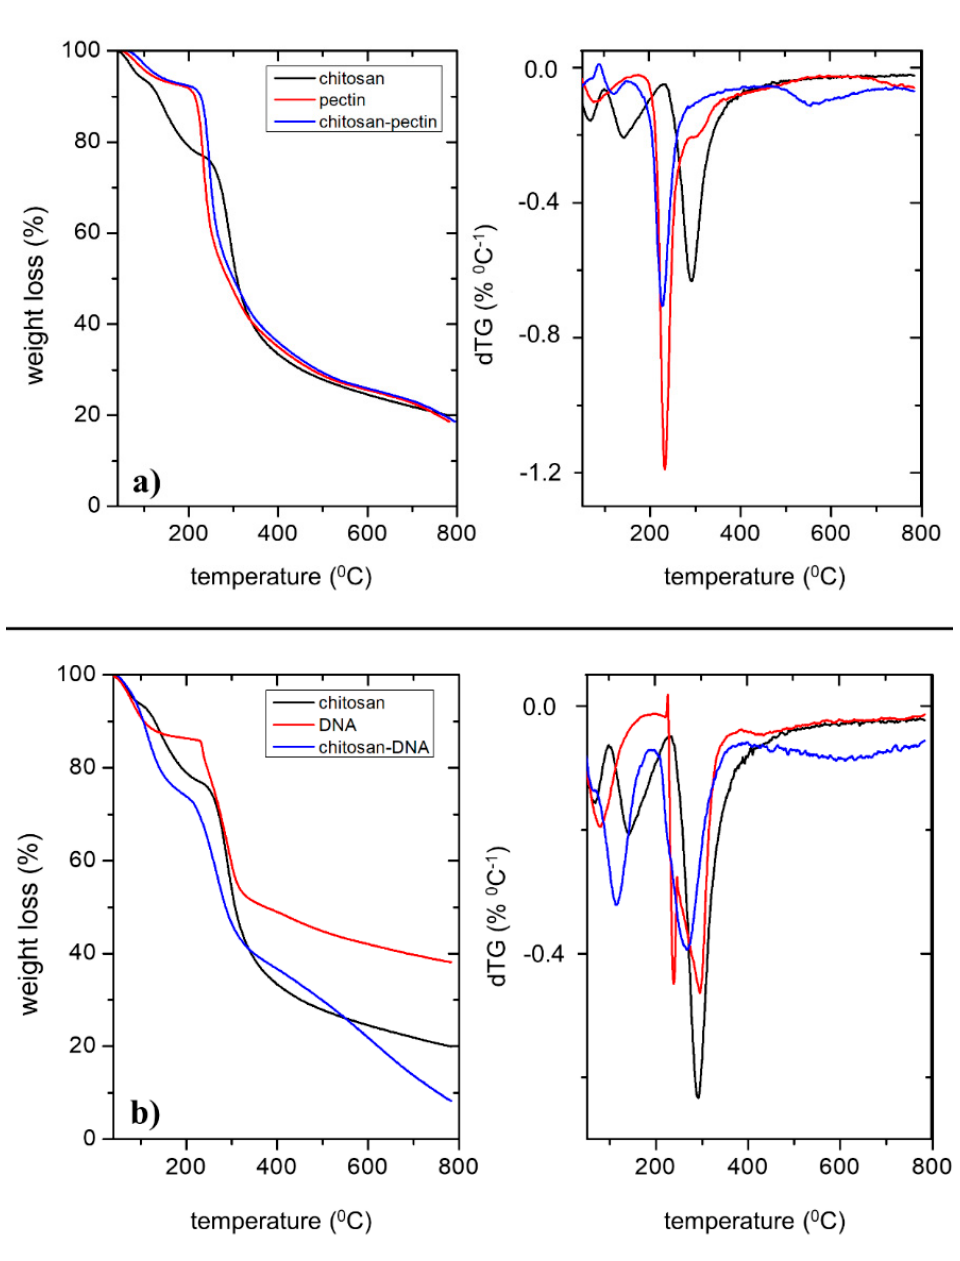
Figure 2. TGA and dTG curves of: ( a ) chitosan ( __ ), pectin ( __ ) and CS-P ( __ ); and ( b ) chitosan ( __ ), DNA ( __ ) and CS-DNA ( __ ).